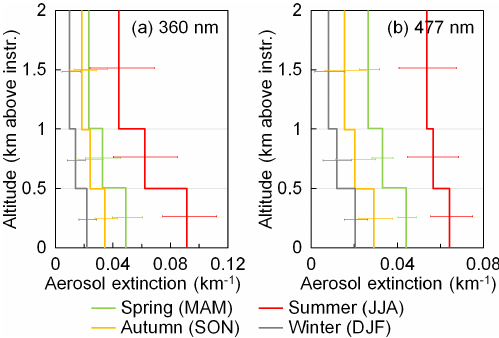
Figure 15. Seasonal average aerosol extinction profiles for (a) 360 and (b) 477nm derived from the long-term measurement results. The error bars represent the averages of the uncertainties calculated by Eqs. (16) and (17).